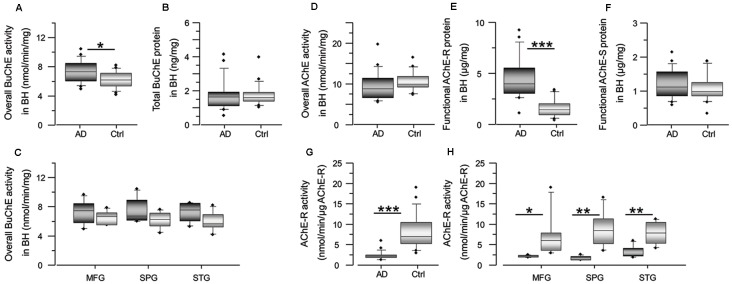
Cholinesterase activity is altered in AD brain, with increase of BuChE activity and decrease of AChE-R activity. Panel (A) shows an increase in the overall BuChE activity in the AD brain compared to the control brain homogenates, normalized to the total protein in the brain extracts. The activity was measured by a modified colorimetric Ellman’s assay. Panel (B) shows the corresponding total BuChE protein levels in the brain homogenates quantified by sandwich ELISA. Panel (C) shows the overall BuChE activity in the AD and the control MFG, STG and SPG brain regions separately. Panel (D) shows that the overall AChE activity is similar in the AD brain compared to the control brain homogenates. The activity was measured by a modified colorimetric Ellman’s assay. Panels (E,F) show the corresponding protein levels of the functionally intact read-through AChE-R and synaptic AChE-S splice variants of the enzyme in the brain homogenates. These were assayed by a functional semi-sandwich ELISA assay, which utilizes the intrinsic activity of the pre-captured enzymes variants for quantification of their relative amounts in the brain homogenates. It is important to note that these analyses reveal accumulation of inactivated AChE-R variant in the AD brain. This is most simply appreciated from the integrated data of AChE-R activity and protein levels shown in (G,H). The rationale is built on the main methodological difference for data acquisition for graph (D) vs. the graph (E or F). For graph (D), all the components of the brain extract are present in the well when the activity of the enzyme is measured, while the graphs (E,F) are based on activity of the enzymes after capturing the enzyme in the wells, pre-coated with antibody against AChE-R (or AChE-S) variant protein. In other words, in this latter assay all other components present in the brain extracts are washed away. Thus, the higher AChE-R in the AD brain extract in the graph (E) means that something in the brain extract had reversibly inactivated the enzyme, and its removal resulted in the re-activation of the enzyme. AD, Alzheimer’s disease (n = 6); Ctrl, non-demented controls (n = 6); BuChE, butyrylcholinesterase; AChE, acetylcholinesterase; AChE-R, “Read-through” AChE splice variant protein; AChE-S, “Synaptic” AChE splice variant protein. Student’s t-test ***p < 0.001, **p < 0.01, *p < 0.05.